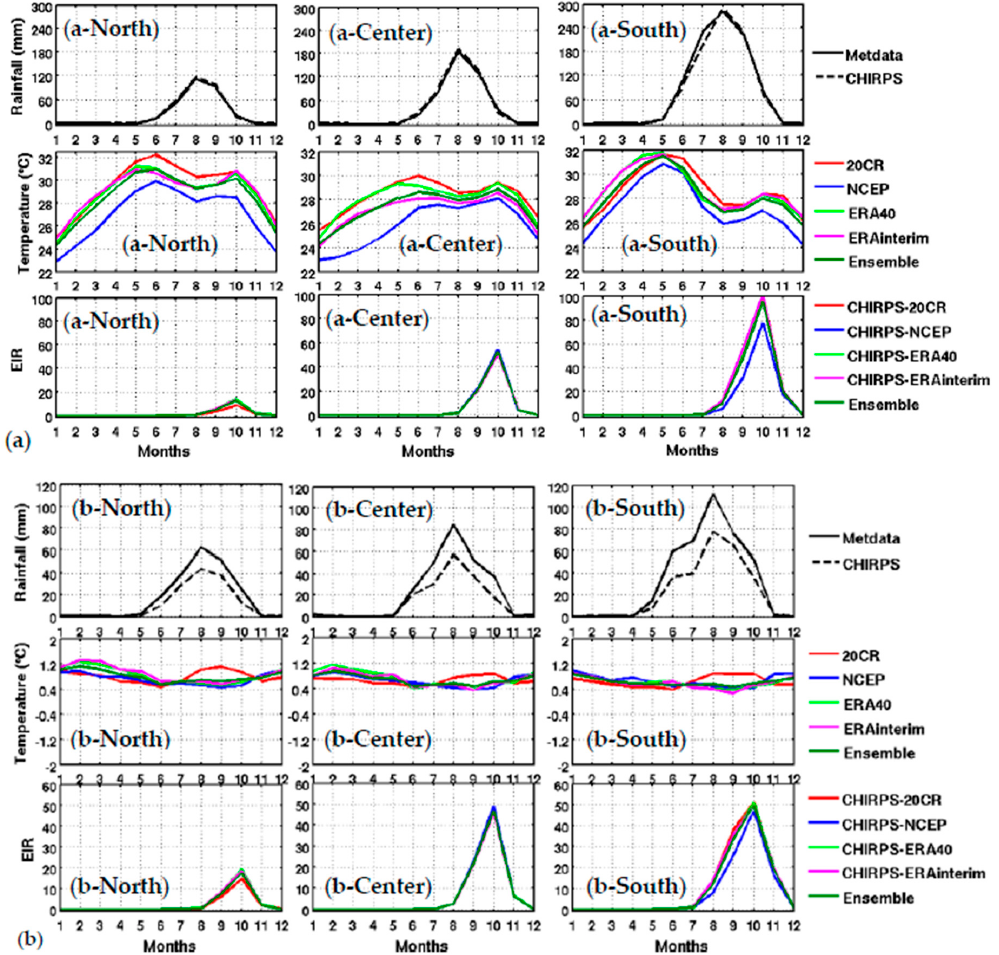
Figure 3. Upper panel: Mean annual cycle of climate parameters and the simulated malaria parameter: ( a ) Meteorological rainfall data based on weather stations (Metdata) and CHIRPS satellite rainfall (CHIRPS), reanalysis temperature (20CR, NCEP, ERA40, and ERA Interim) and simulated EIR based on CHIRPS rainfall and reanalysis temperature (CHIRPS-20CR, CHIRPS-NCEP, CHIPRS-ERA40, CHIRPS-ERA Interim, and the ensemble mean of all reanalyses), for different Senegal zones (northern in column 1: spatial average for Saint-Louis, Louga, and Matam), central in column 2 (spatial average for Dakar, Thies, Kaolack, Fatick, and Diourbel) and southern in column 3 (spatial average for Ziguinchor, Kolda, and Tambacounda) for the period 1981–2001. Lower panel: ( b ) idem as the upper panel, but for the standard deviations